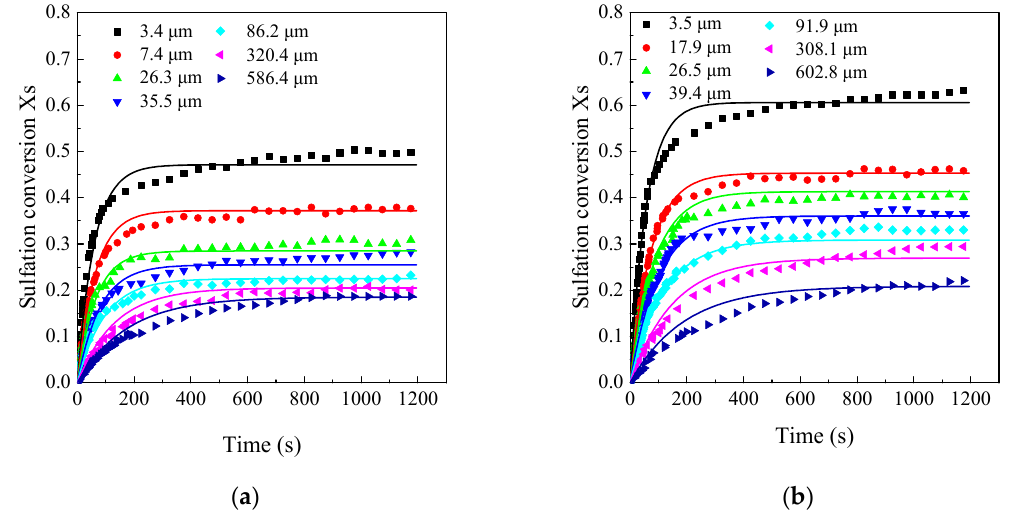
Figure 8. Effects of limestone particle size on the CaO sulfation reactivity (the large capacity TGA, 850 °C, 2000 ppm): ( a ) Samcheok; ( b ) Shengzhou.